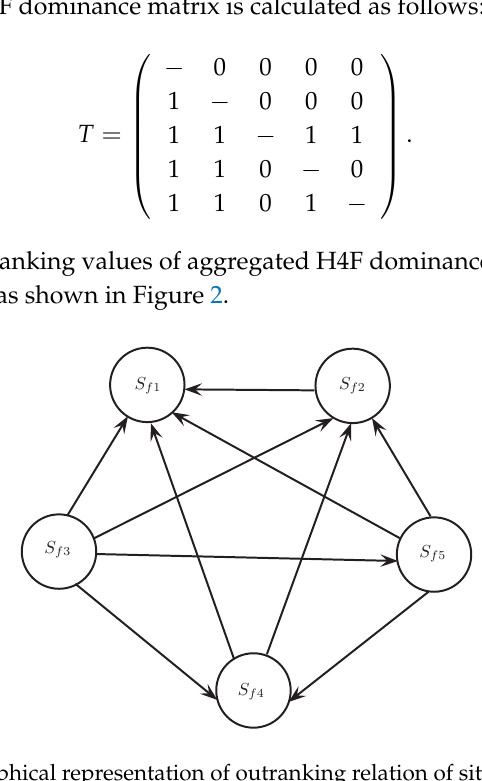
Figure 2. Graphical representation of outranking relation of sites for farming.